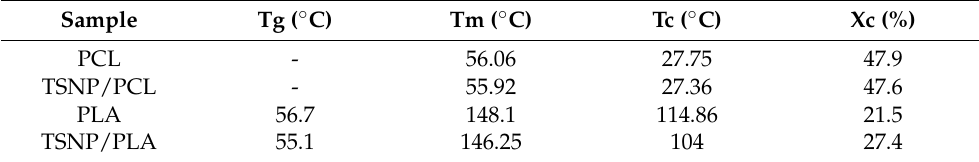
Figure 6. DSC curves for ( a ) bare and treated PCL films and ( b ) bare and treated PLA films. Table 1. Thermal characteristics of the pure and TSNP-treated